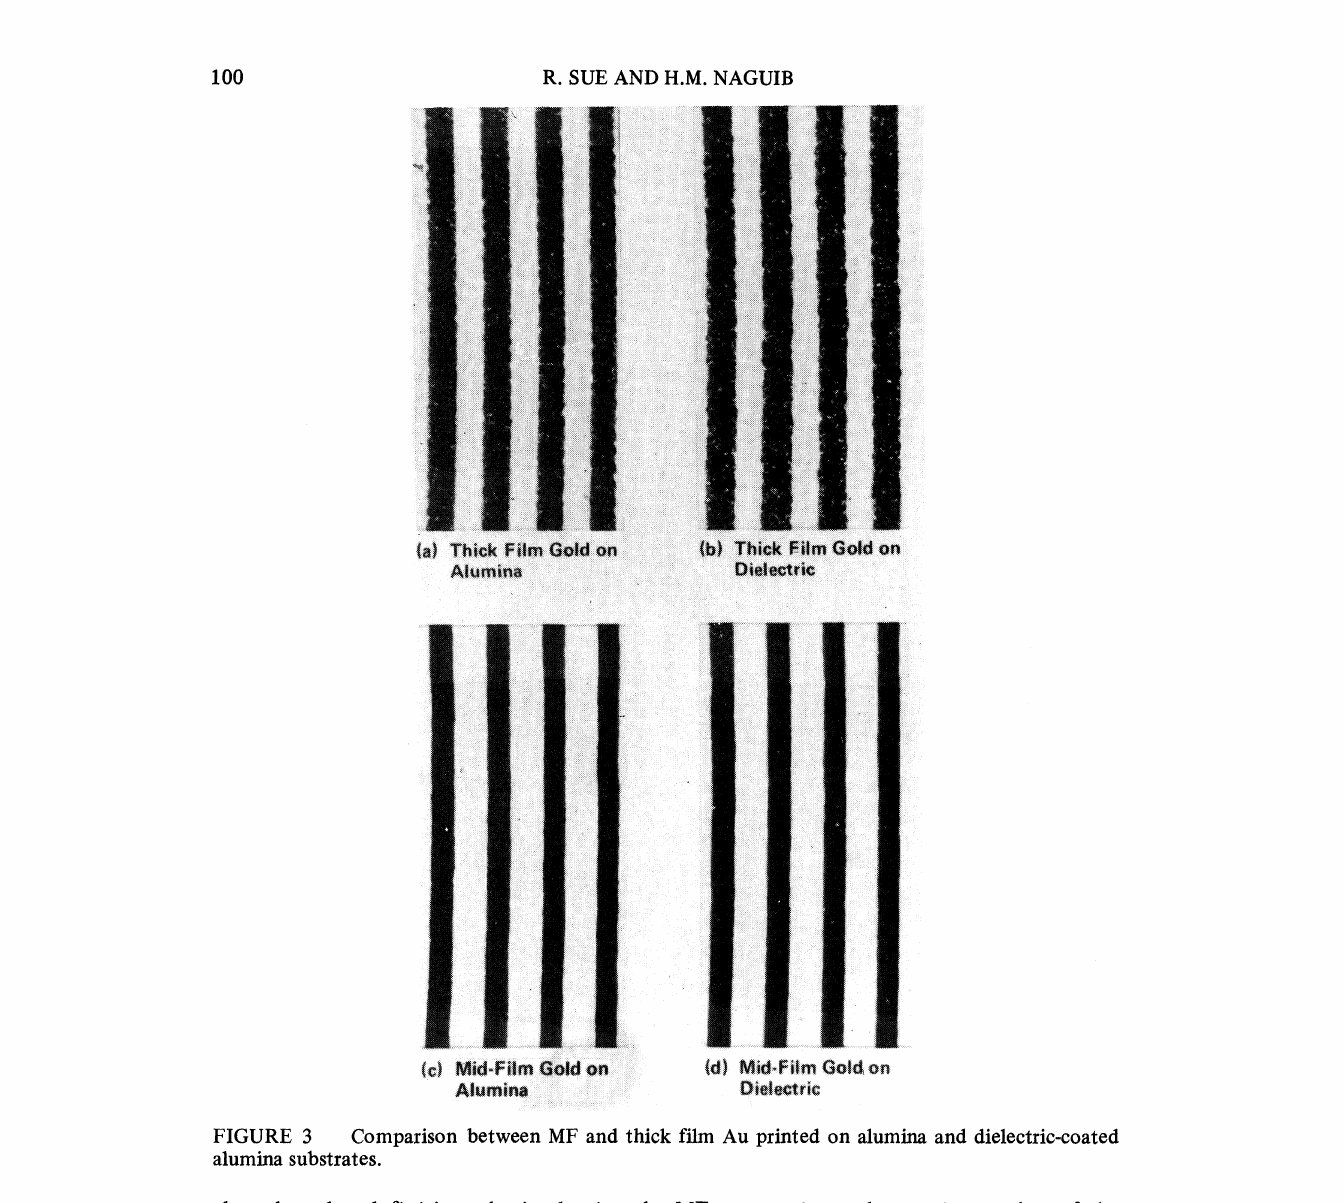
FIGURE 3 Comparison between MF and thick film Au printed on alumina and dielectric-coated alumina